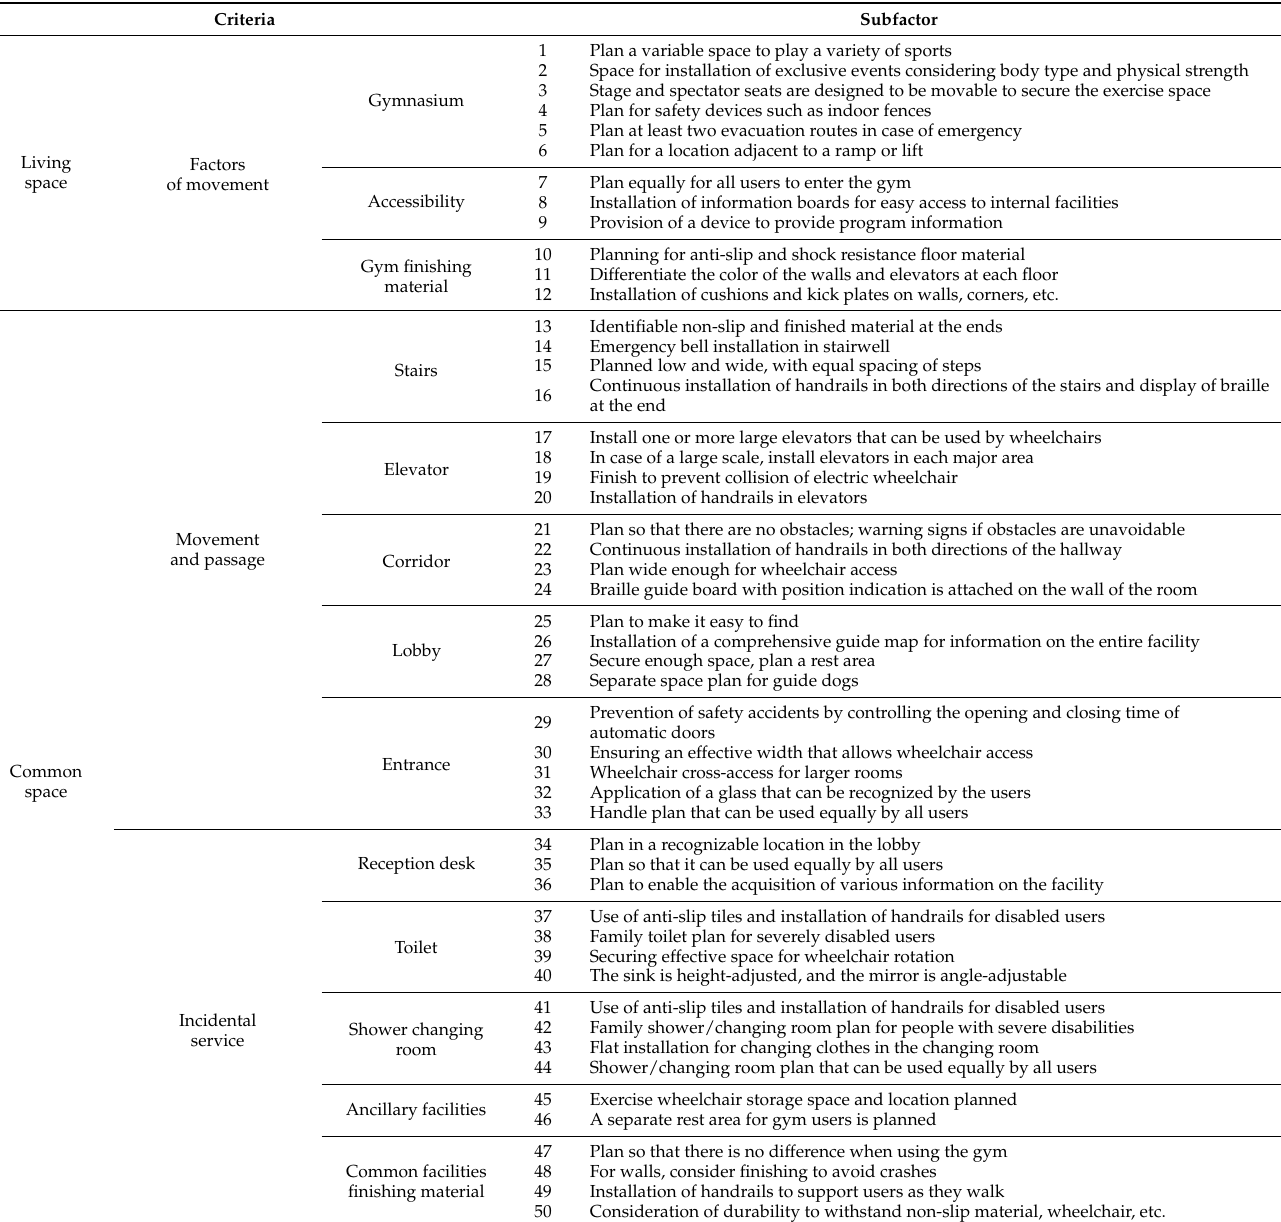
Table 4. Criteria and sub-factors of the first Delphi